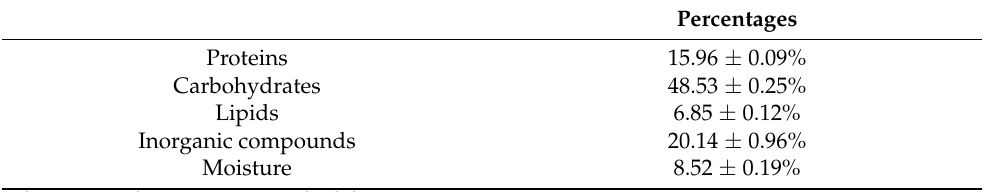
Values reported are means ± standard